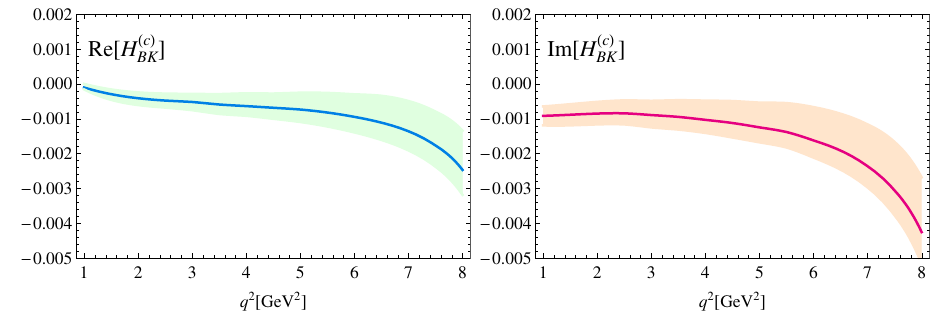
Figure 2 . Hadronic nonlocal amplitude H ( c ) ( q 2 ) in B (cid:0) ! K (cid:0) ‘ + ‘ (cid:0) in the large recoil region. On BK the left (right) panel the real (imaginary) part is plotted for the central input (solid) and including uncertainties (dashed band).